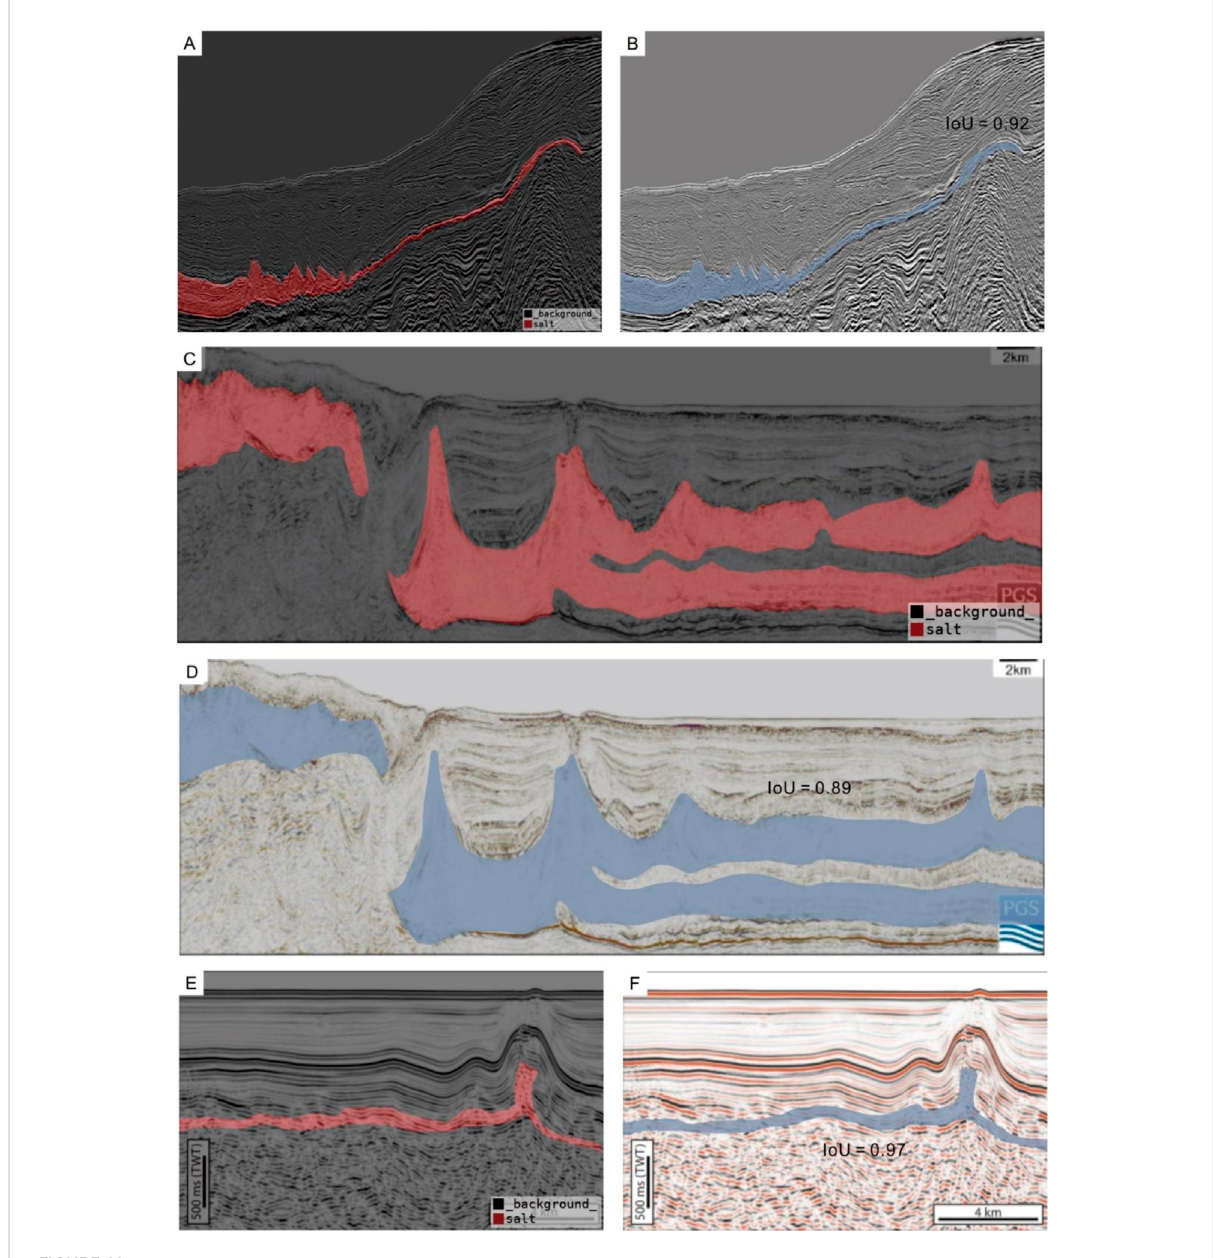
FIGURE 11 The ultrascale salt reconstruction algorithm performance for ultrascale salt identi fi cation (A) and (B) come from (Elfassi et al., 2019); (C) and (D) come from (Maunde and Alves, 2022); (E) and (F) come from (Soto et al., 2022).